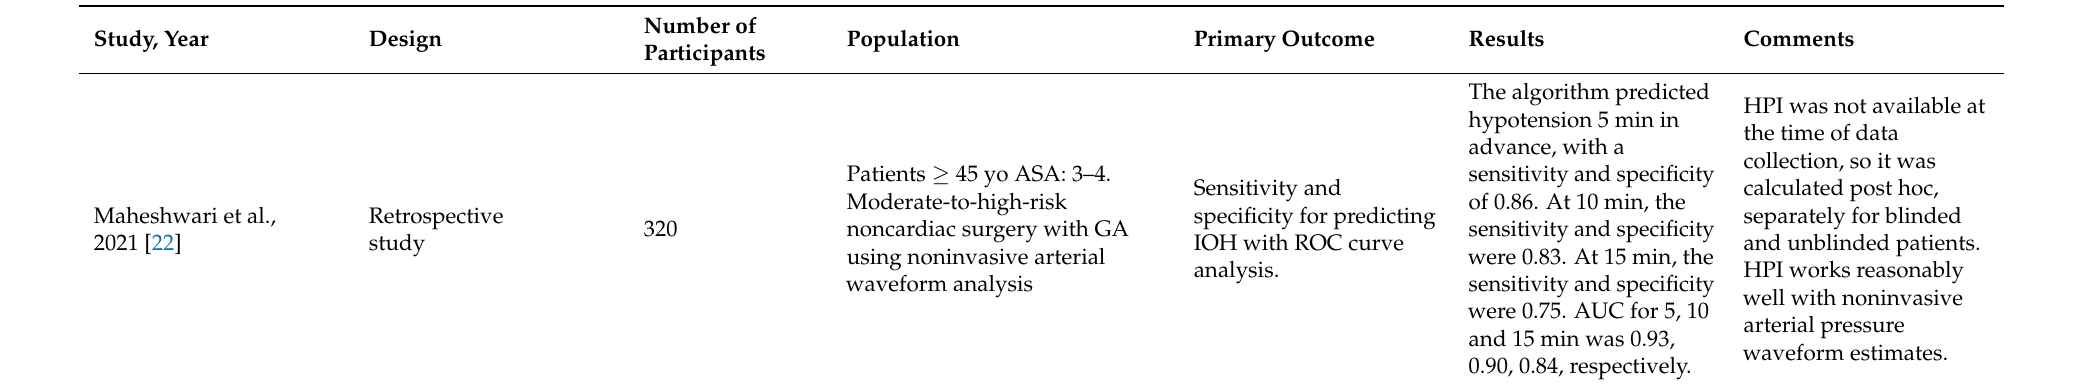
Table 2. Trials validating the HPI algorithm using noninvasive arterial waveform